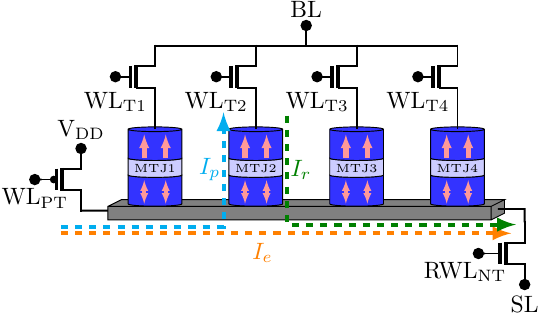
Figure 4. 4-bit NAND-SPIN